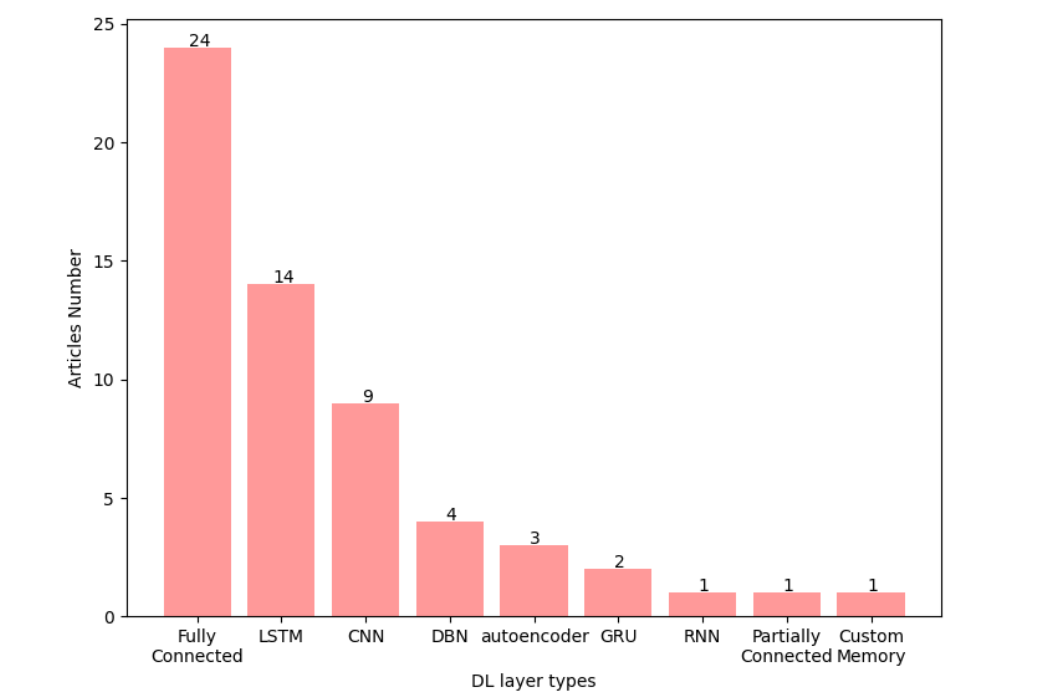
Figure 3. Most common deep learning techniques for